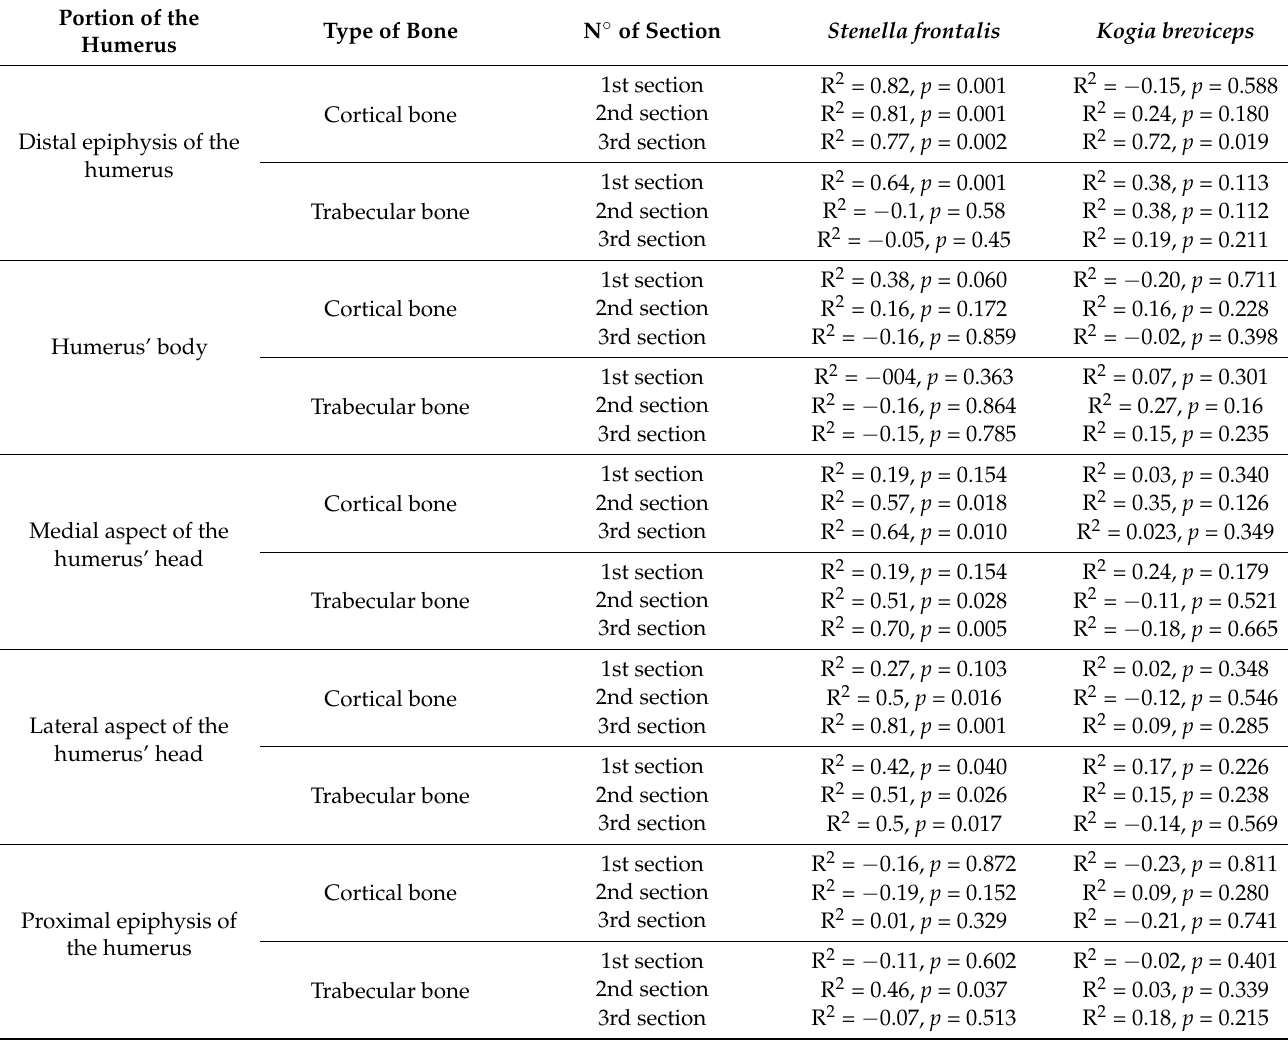
Table 3. Summary table of the different regression lines obtained for the two cetacean species considering the radiodensity values of the two types of bone by